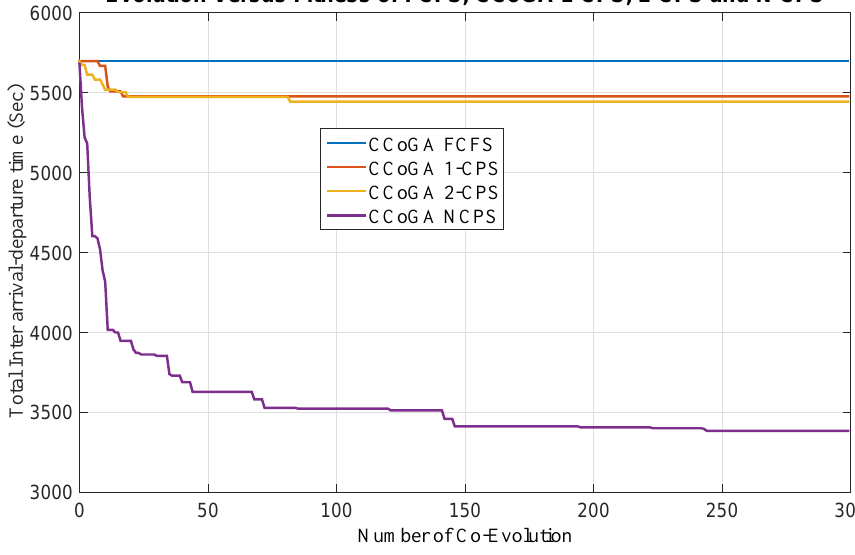
Figure 7. Evolution of aircraft sequence and runway configuration. The N-CPS took the longest time, and solution converges at 300